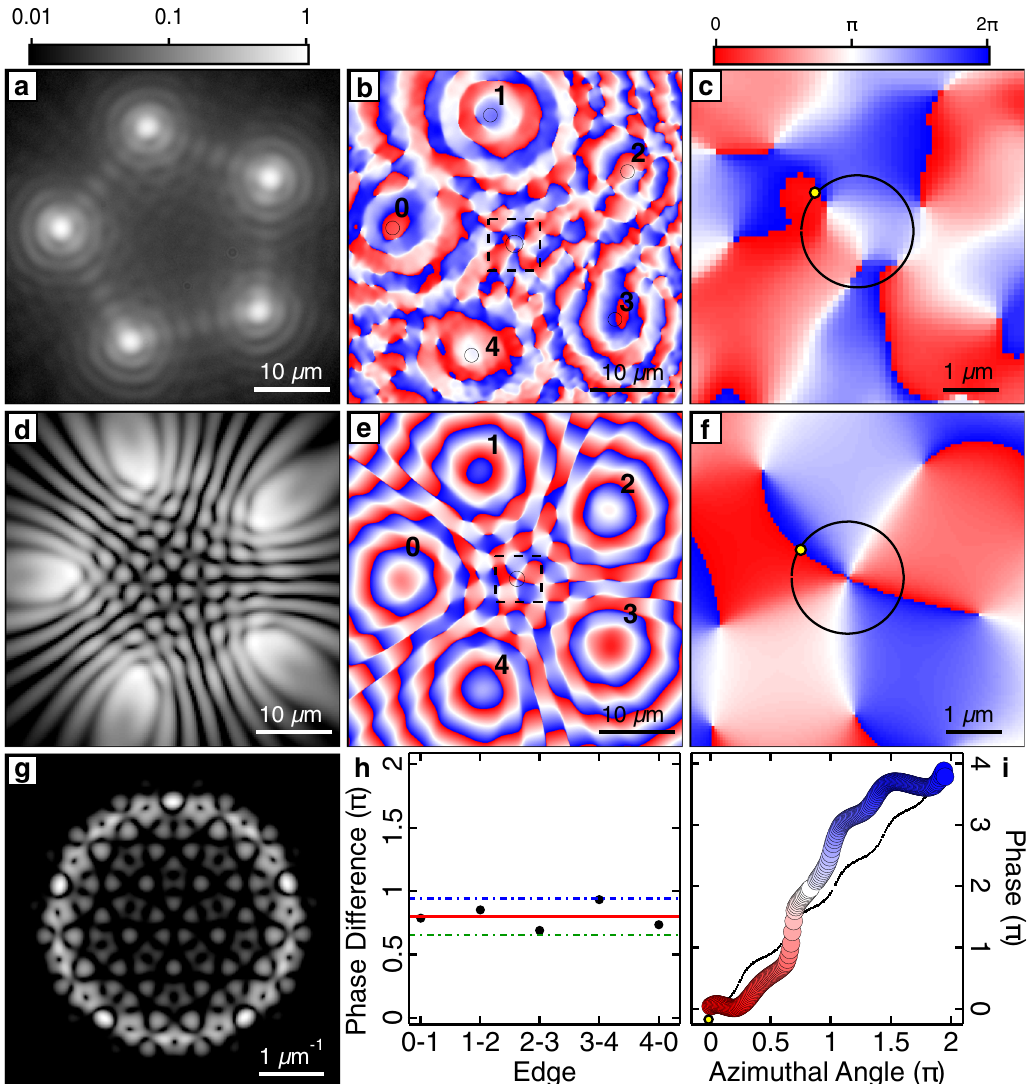
Fig. 4 Single shot of a pentagon of polariton condensates with a doubly charged vortex at the centre. Pentagon condensate with a charge m = 2 vortex. a Experimental real-space PL and b , c phase extracted from interferometry from a single instance of the condensate. Simulated steady state m = 2 vortex wavefunction d real-space density, g Fourier-space density, and e , f real-space phase. c , f Zoomed-in regions of the dashed squares in b , e , respectively. h Phase difference between adjacent condensates (black dots) around the polygon extracted from the black circles in b . The red line is the expected phase difference of θ i , i + 1 = 4 π /5. Green and blue dash-dotted lines mark the maximum deviation. i Line pro fi le extracted along the black circle in c , f demonstrating a full 4 π phase winding. Yellow dots correspond to azimuthal angle equal to zero. Experimental data are represented by the coloured disks and numerical simulation by the black-dotted